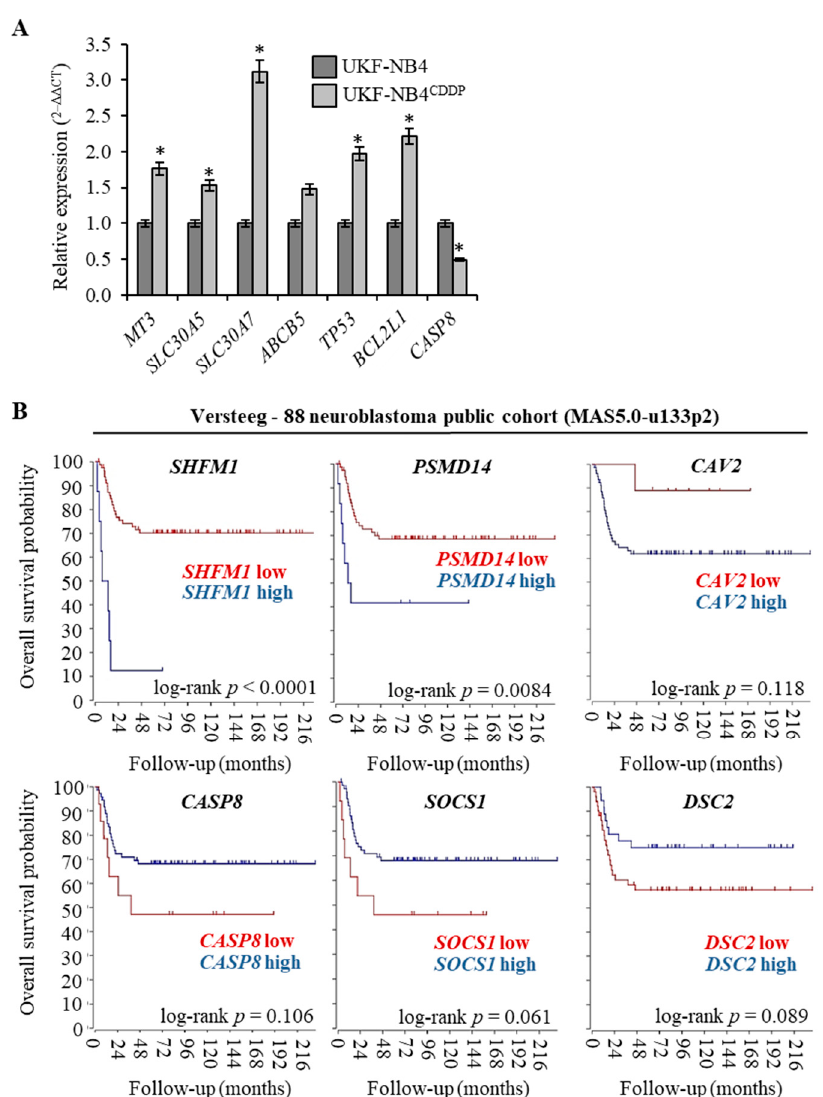
Figure 2. Analysis and validation of cDNA microarray data. ( A ) The quantitative polymerase chain reaction (qPCR) validation of expression of six up-regulated and one down-regulated genes identified by microarray analysis. The data are results from three independent experiments. * p < 0.01 related to parental cells. ( B ) Kaplan-Meier curves showing the overall survival of Nbl patients ( n = 88) with tumors expressing SHFM1 , PSMD14 and CAV2 (genes up-regulated in UKF-NB-4 CDDP cells, top panel ) and CASP8 , SOCS1 and DSC2 (genes down-regulated in UKF-NB-4 CDDP cells, bottom panel ). The p values were determined using a log-rank test. The R2: Genomics Analysis and Visualization Platform was used for the calculation. Versteeg NB88 neuroblastoma public cohort (MAS5.0-u133p2) was the source of the